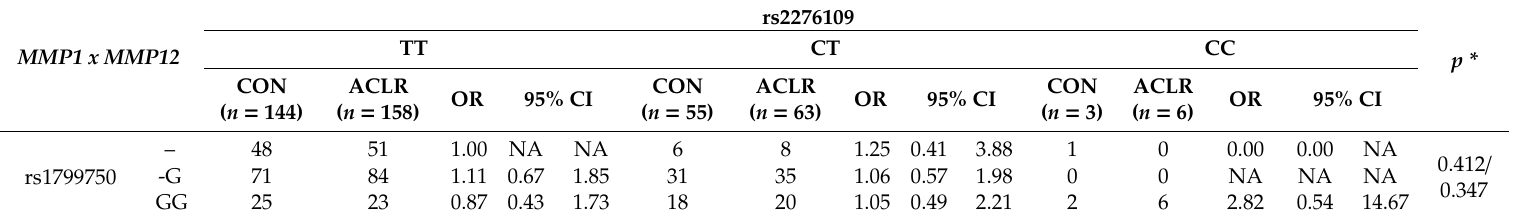
Table 4. Association analysis of the MMP1 x MMP12 interaction with non-contact ACL rupture (codominant model).